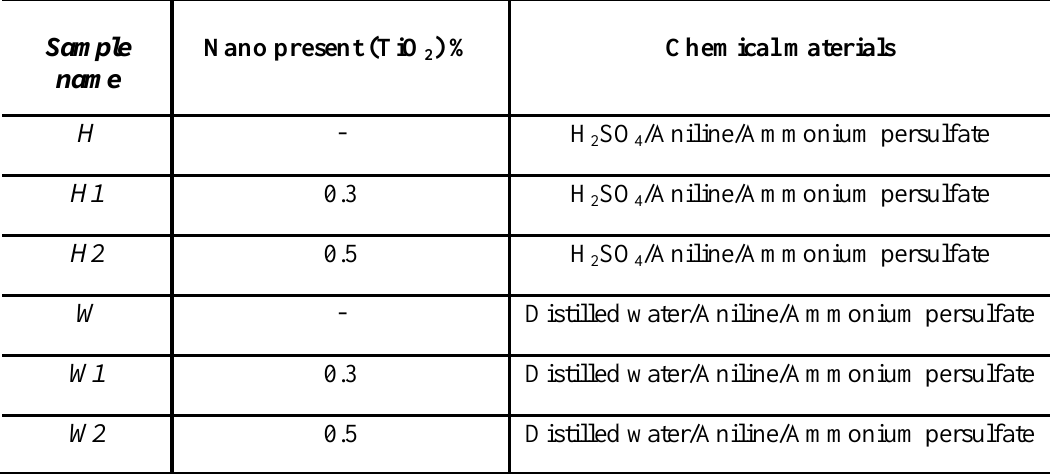
Table 1: The name of the samples and percentage of the